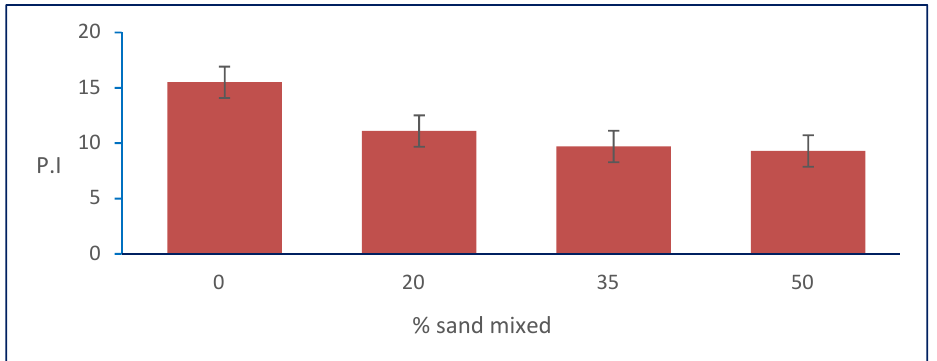
Figure 11. Effect of sand on PI.